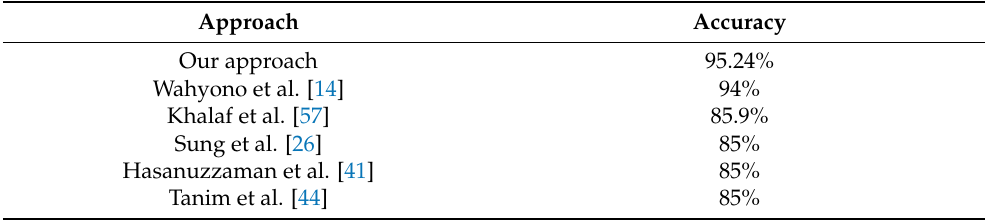
Table 5. Comparing our approach with those that used Accuracy as a